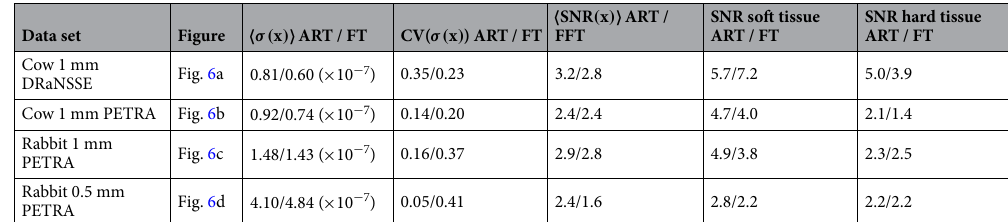
(cid:31) SNR ( x ) (cid:30) ART /